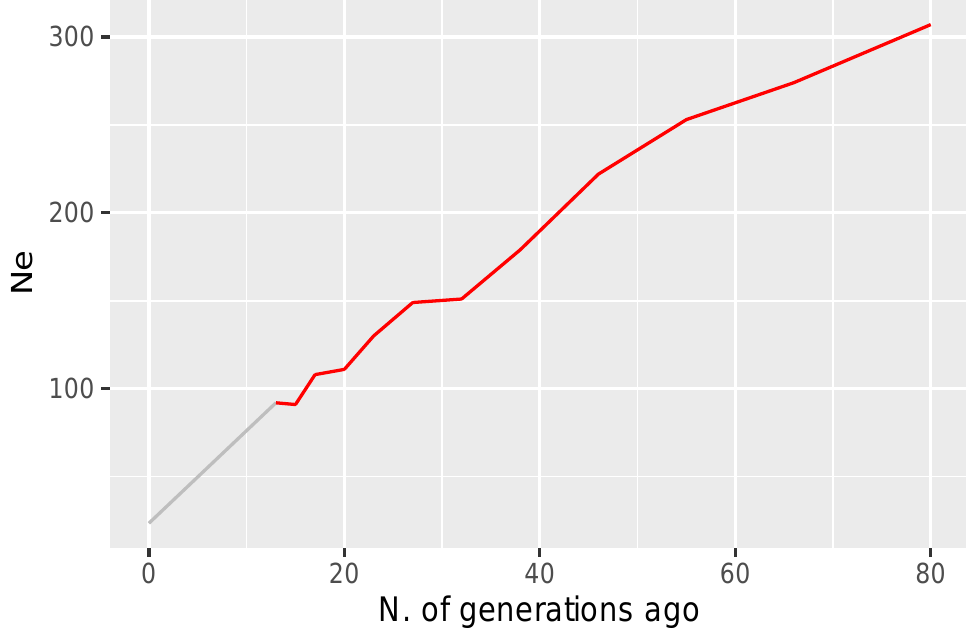
Figure 7. Historical (from SNeP ) and current (from Neestimator ) estimates of effective population size (Ne) in Maremmana